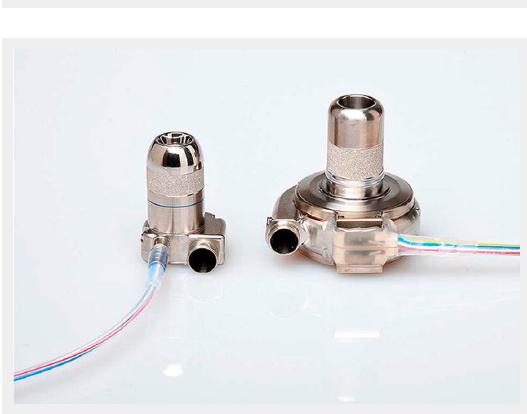
Surgical technique: the minimal invasive approach. Patient’s head is on the right hand side. Left anterior thoracothomy to expose cardiac apex and insert the inflow cannula (A), the mini right anterior thoracotomy to expose the ascending aorta to suture the outflow graft (B) and the point where the driveline pierces the skin